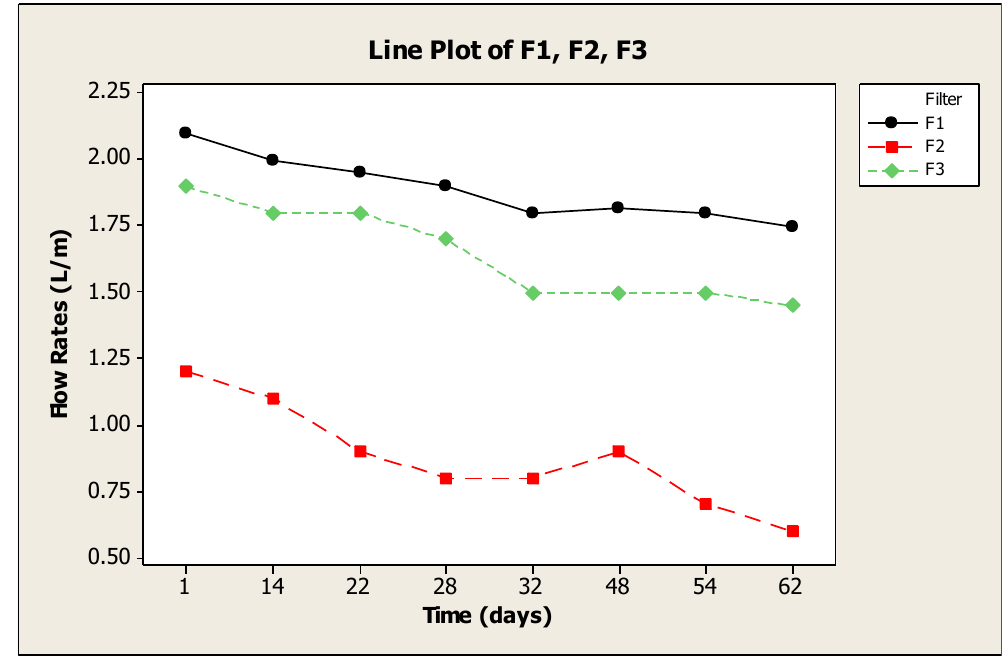
Figure 4. Filtration rate upon initial 20 L charge of water over the course of three filter microbial challenge experiments. Line Plot of F1, F2,